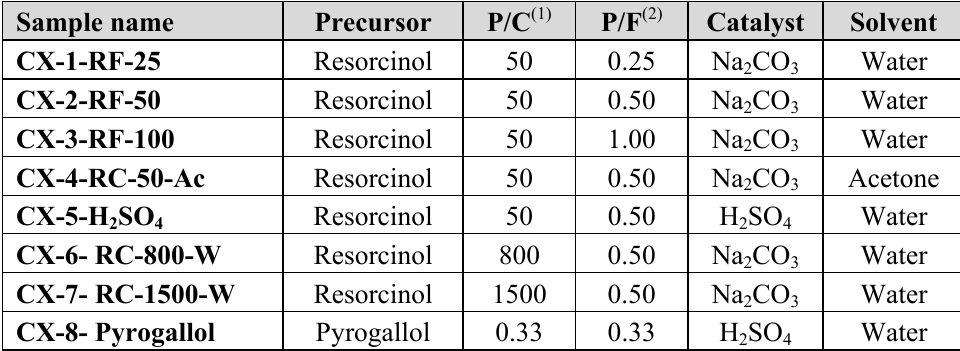
Table 6. Carbon xerogel synthesis